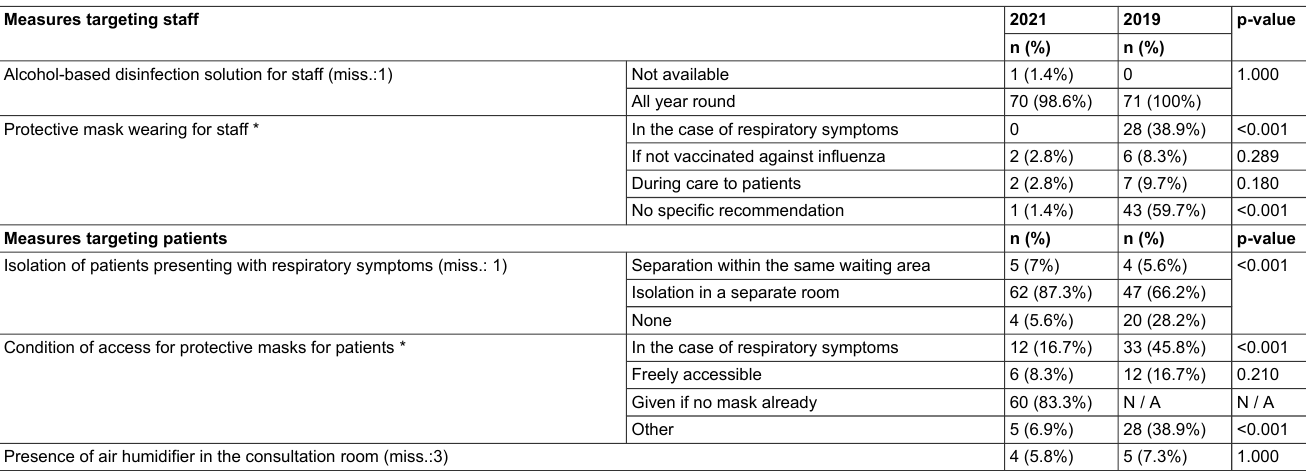
Table S3: Infection prevention and control measures in the Sentinella network with data for both 2021 and 2019 surveys (72 answering practices). Paired analysis with p-values from exact McNemar test (proportions) and Wilcoxon signed rank test (counts or ordinal). Measures targeting staff